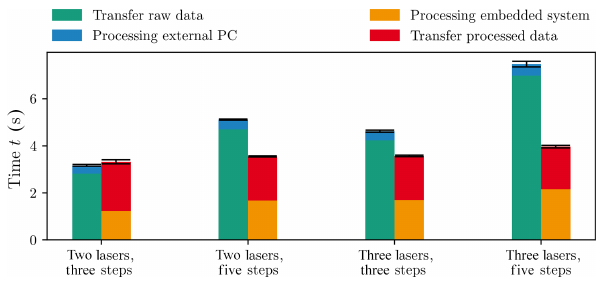
Figure 6. Comparison of transmission of raw data (green) with external data evaluation (blue) to internal data evaluation (orange) with reduced data transmission (red). The latter configuration pays off with at least three lasers and/or five phase